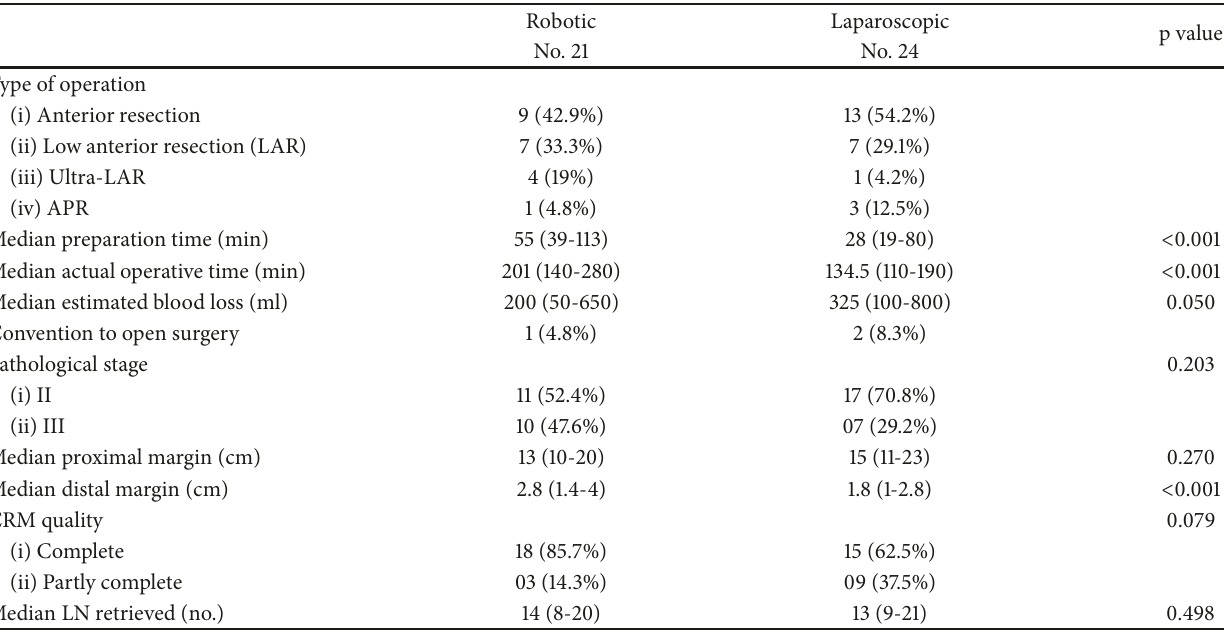
Table 2: Operative data. Robotic